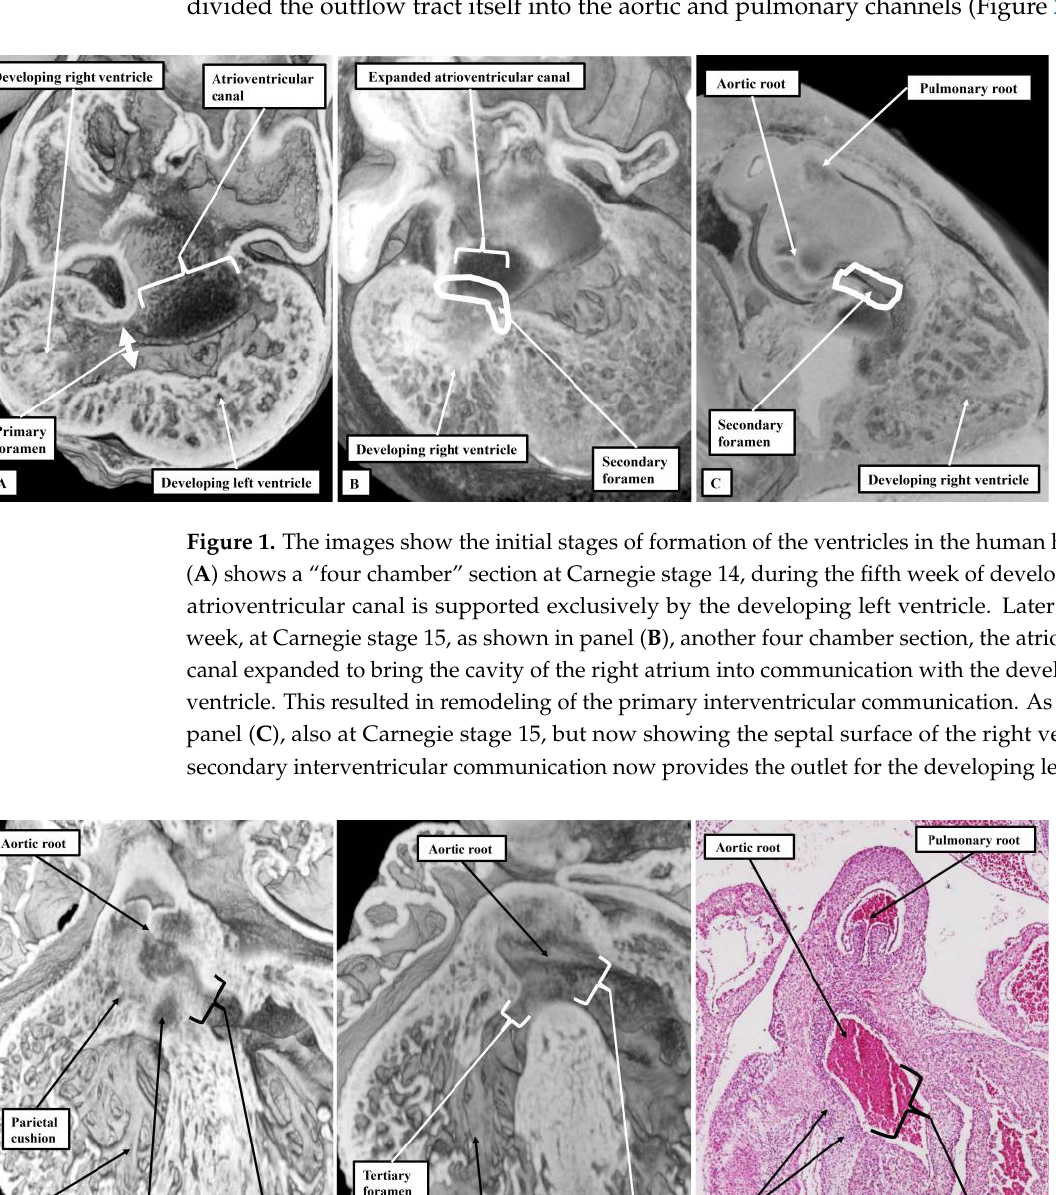
Figure 2. The images show the changes involved during transfer of the aortic root from the devel- oping right to the developing left ventricle. Panels ( A , B ), in four chamber projection, are from the same mouse embryo sacrificed at embryonic day 13.5. Panel ( A ) shows how the proximal outflow cushions have fused to produce a partition at the base of the ventricle beneath the aortic root. Panel ( B ), a dorsal section from the same heart, shows how a tertiary foramen remains between the root and the cavity of the right ventricle. Panel ( C ), from a human embryo at Carnegie stage 21, shows